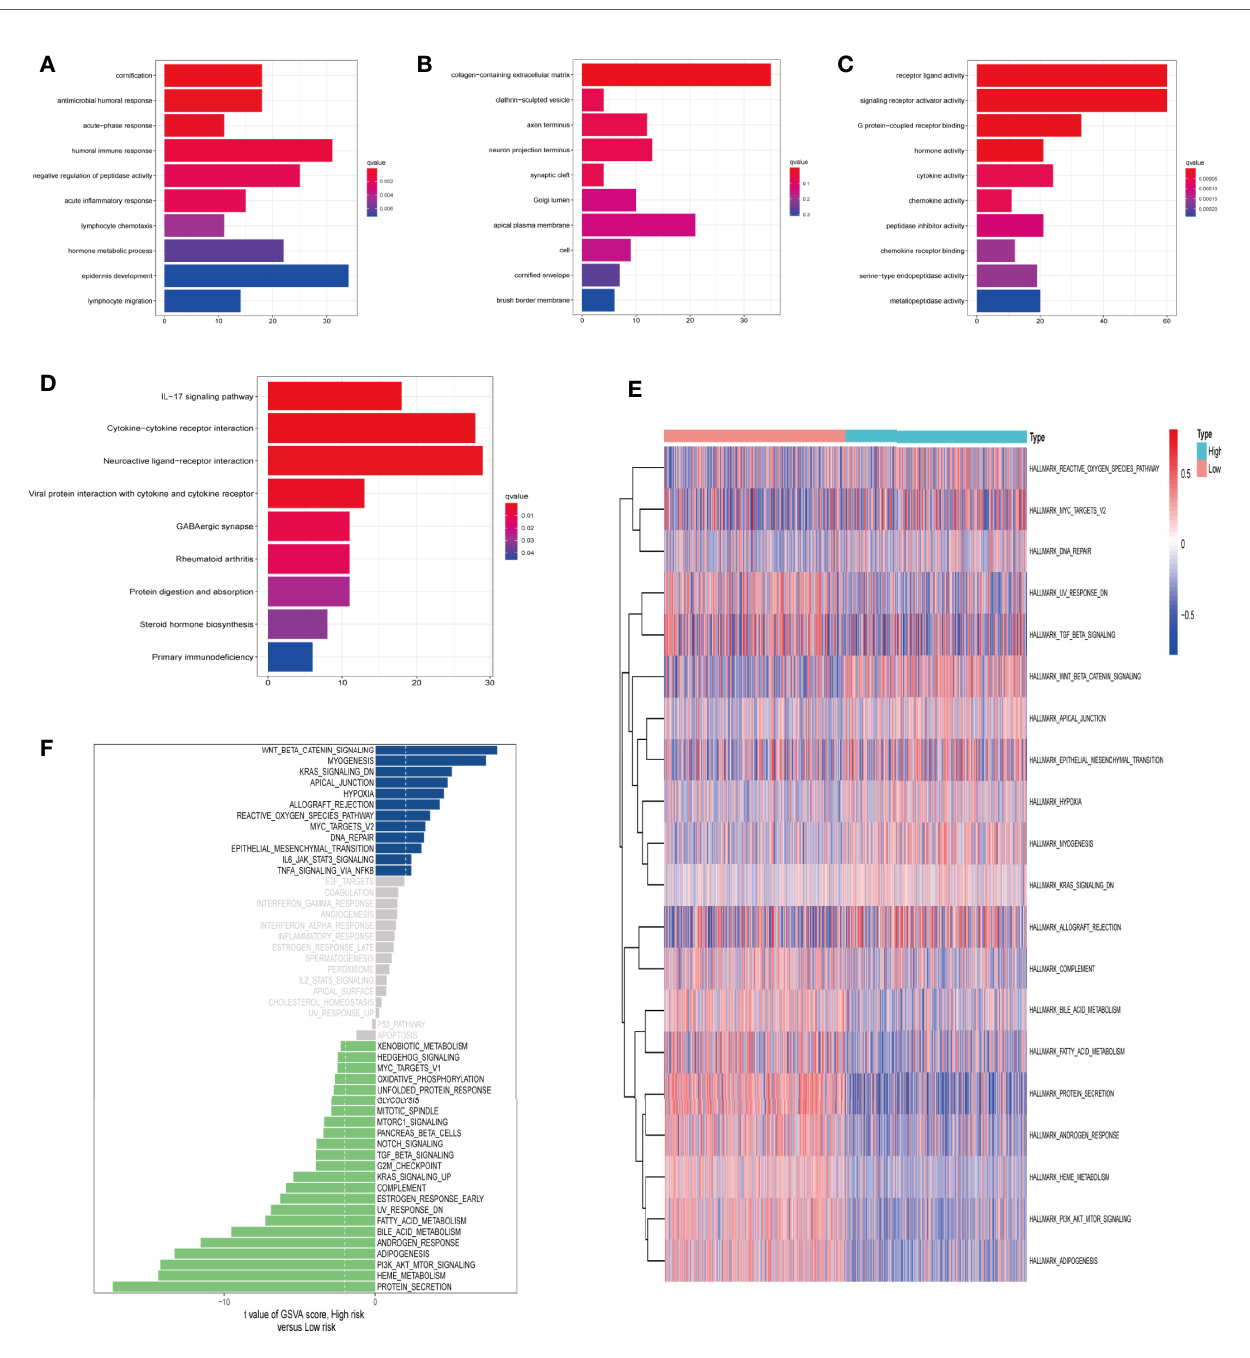
FIGURE 8 | Functional enrichment analysis and Gene Set Variation Analysis (GSVA). Go enrichment analysis of differentially expressed genes, including (A) Biological Process (BP), (B) Cellular Component (CC), (C) Molecular Function (MF). (D) KEGG enrichment analysis of differentially expressed genes. GSVA analyzed the relationship between prognostic gene characteristics and tumor characteristics. (E) Heat map. (F)